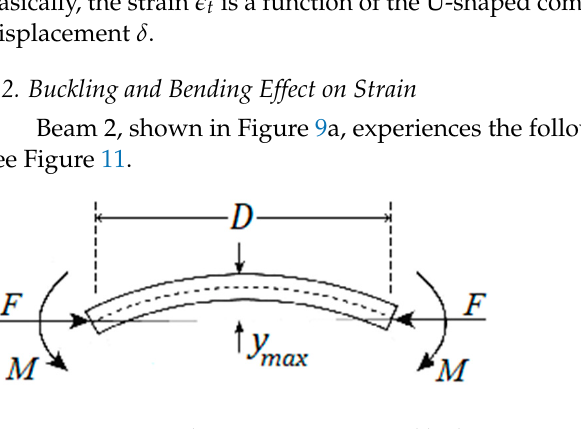
Figure 11. Forces and moments experienced by beam 2.